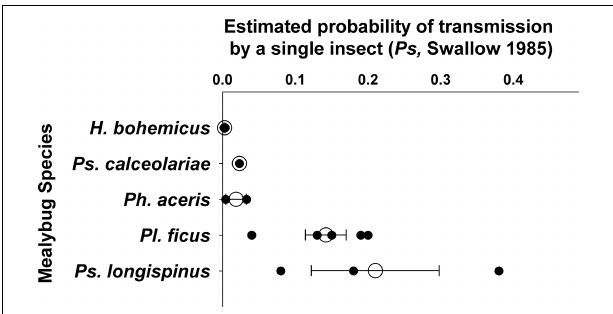
FIGURE 2 | Estimated transmission efficiency of GLRaV-3 per individual per day ( P s; per Swallow, 1985) by different mealybug species, including studies that tested transmission by first and/or second instars, nymphs, adults, or mixed life stages, and used access periods of 1 day or longer. When available, only earliest life stages tested are included. From individual publications including multiple experiments, those experiments are combined to produce one estimate of P s for each mealybug species. Results are based on a limited number of peer-reviewed publications per species; Pl. ficus – 5, Ps. longispinus – 3, H. bohemicus and Ph. aceris – 2, and Ps. calceolariae – 1. Figure shows P s for individual publications (dark circles), mean (open circles), and standard error.